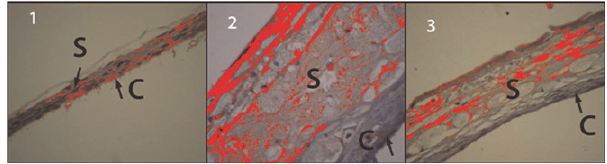
Figure 2 - C - Choroid; S - Sclera. 1 ) GI sclera and choroid. The prevalence of the bluish color demonstrates the low levels of immunoreactivity to ICAM-1. 2 ) GII sclera and choroid. The prevalence of the orange color demonstrates the high levels of immunoreactivity to ICAM-1. 3 ) GIII sclera and choroid. The orange areas indicate immunoreactivity to ICAM-1. Specifically, this reactivity was higher than in GI and lower than in